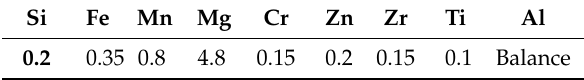
Table 3. Chemical composition of 5087 filler wire (in wt.%).